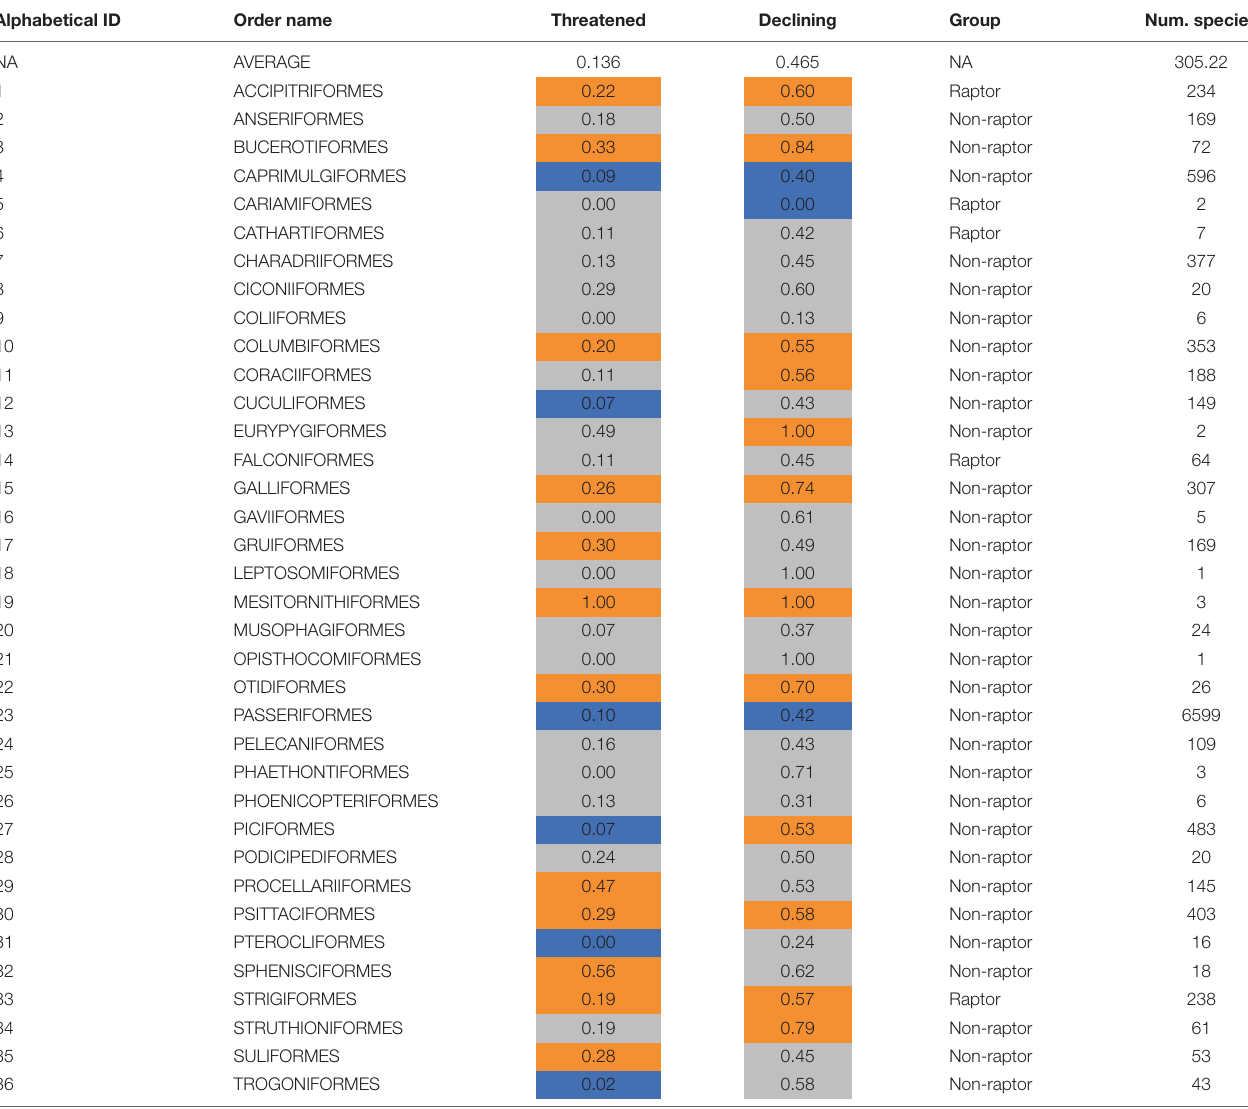
TABLE 1 | Median of proportions of threatened and declining species per bird order. Orders are more than average (orange) if the 95% CRI of the difference between the order’s proportion and the average is negative, and less than average (blue) if that value is